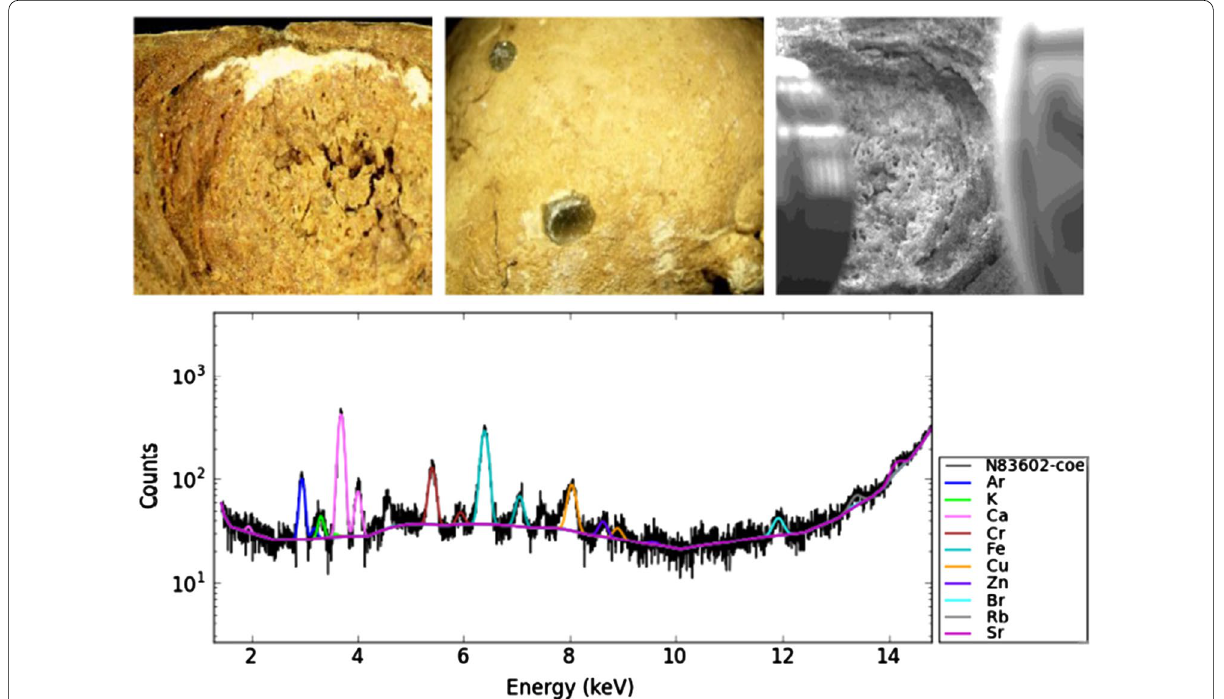
Fig. 1 Illustration of a stone analyzed with its X‑ray fluorescence spectrum